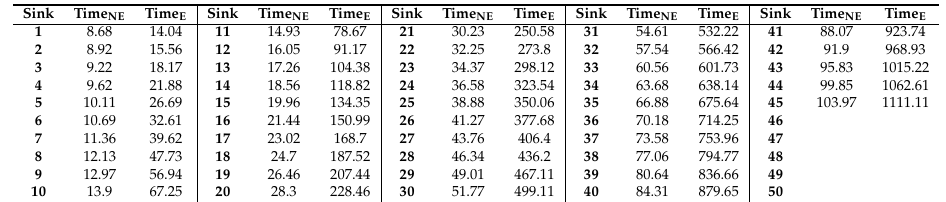
Table A15. Scenario 5: transmission times (in s) for each sink all over the transmission line. (Distance between poles is equal to 300 m, κ = 1, η = 45, NE means no encryption, E means